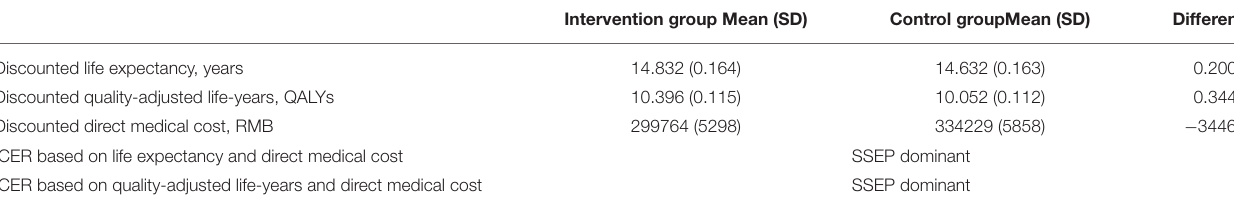
TABLE 3 | Long-term cost-effectiveness outcomes (50 years).